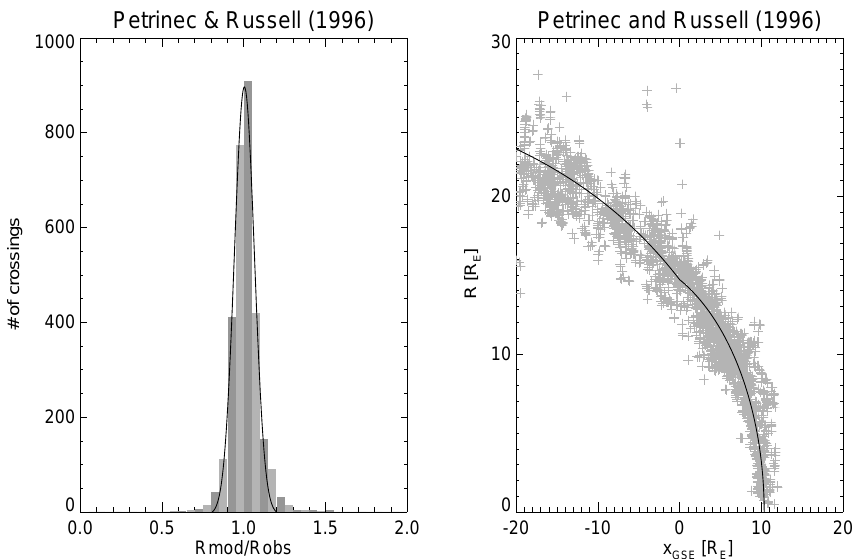
Fig. 1. Histogram of R mod /R obs ratios for the PR96 model (left part) and the position of the observed magnetopause crossings in aberrated coordinates scaled to the solar wind dynamic pressure and IMF B Z (right part). The heavy line represents the PR96 magnetopause under standard conditions ( p SW = 2nPa, IMF B Z = 0).